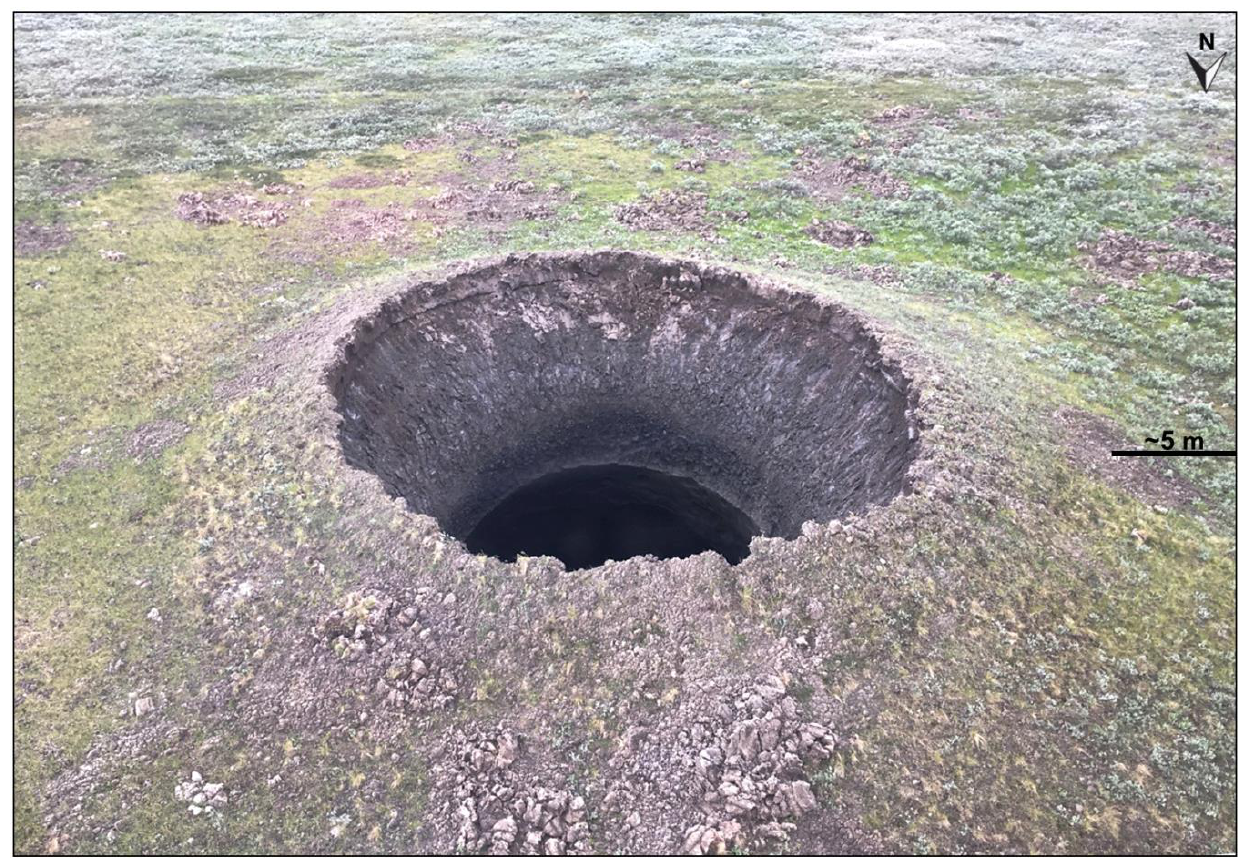
Figure 1. The first photo of the C17 crater from the helicopter taken by Andrey Umnikov on July 16, 2020.